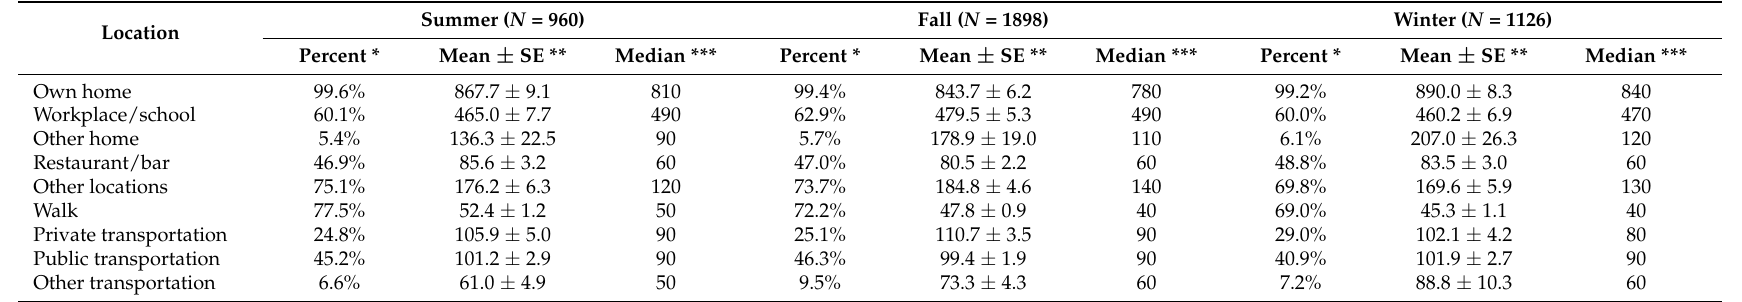
Table 2. The amount of time spent by those who visited nine locations in Seoul over three seasons.